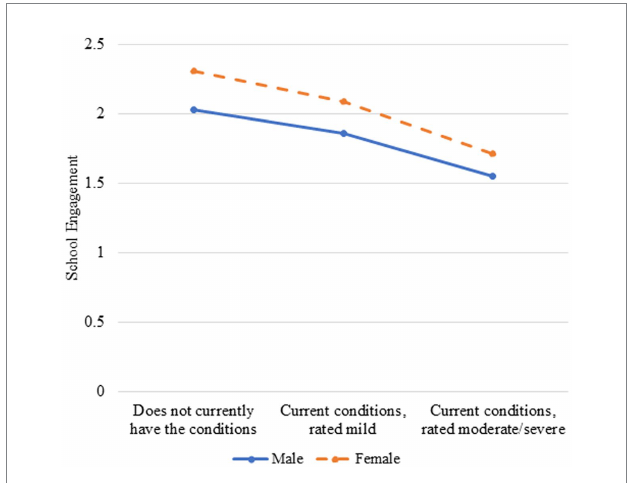
FIGURE 1 Difficulties making and keeping friends and speech-language disorder severity moderated by sex for English